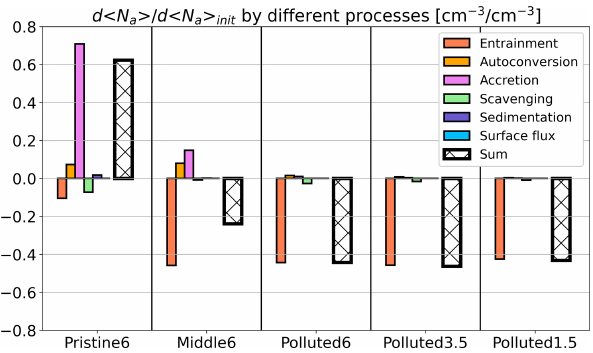
Figure 9. Fractional changes in the initial N a perturbation resulting from different microphysical responses to aerosol injection, aver- aged across the 2d simulation: entrainment (red), autoconversion (orange), accretion (magenta), scavenging (green), and surface flux (blue). The thick hatched bars represent the sum of all of the budget